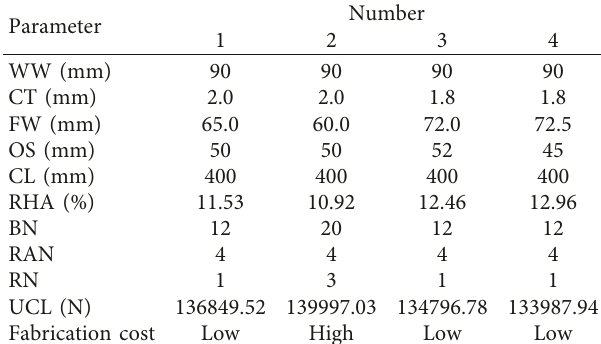
Figure 17: (a) The ROC curve between real measurement and ANN prediction. (b) The ROC curve between real measurement and FEM simulation. Table 6: Centerline and weight of the